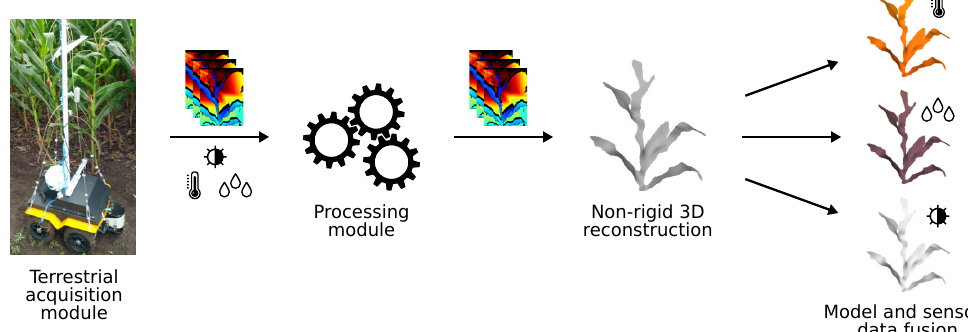
Figure 1. Proposed system macro view. The terrestrial acquisition module collects temperature, humidity, and luminosity data and RGB-D videos; the processing module performs a non-rigid 3D reconstruction of the plants and merge the sensors data into these models. With these modules, the system is able to generate inputs for phenotyping